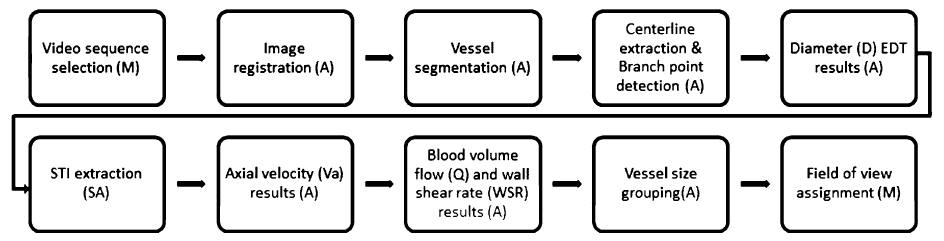
Figure 2. Flow-chart illustrating the individual processing stages from image registration to results output. Each step is labelled as automatic (A), manual (M) or semiautomatic